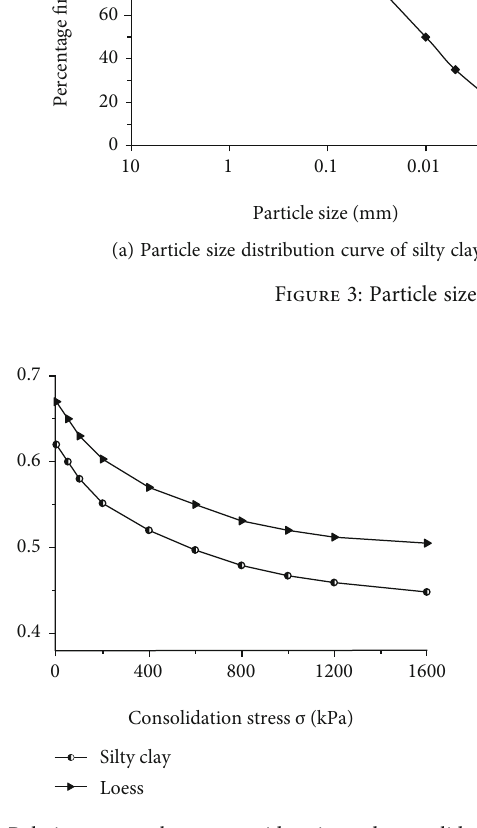
Figure 4: Relation curves between void ratio and consolidation